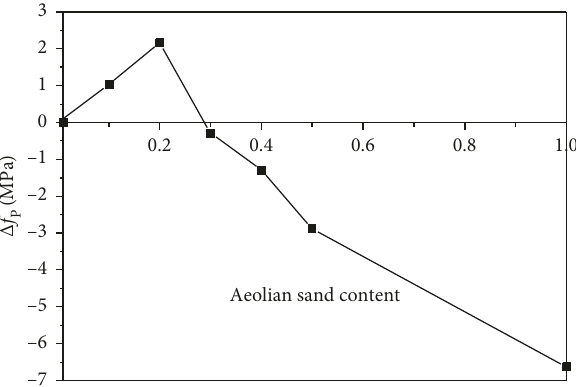
Figure 17: Relation between Δ f